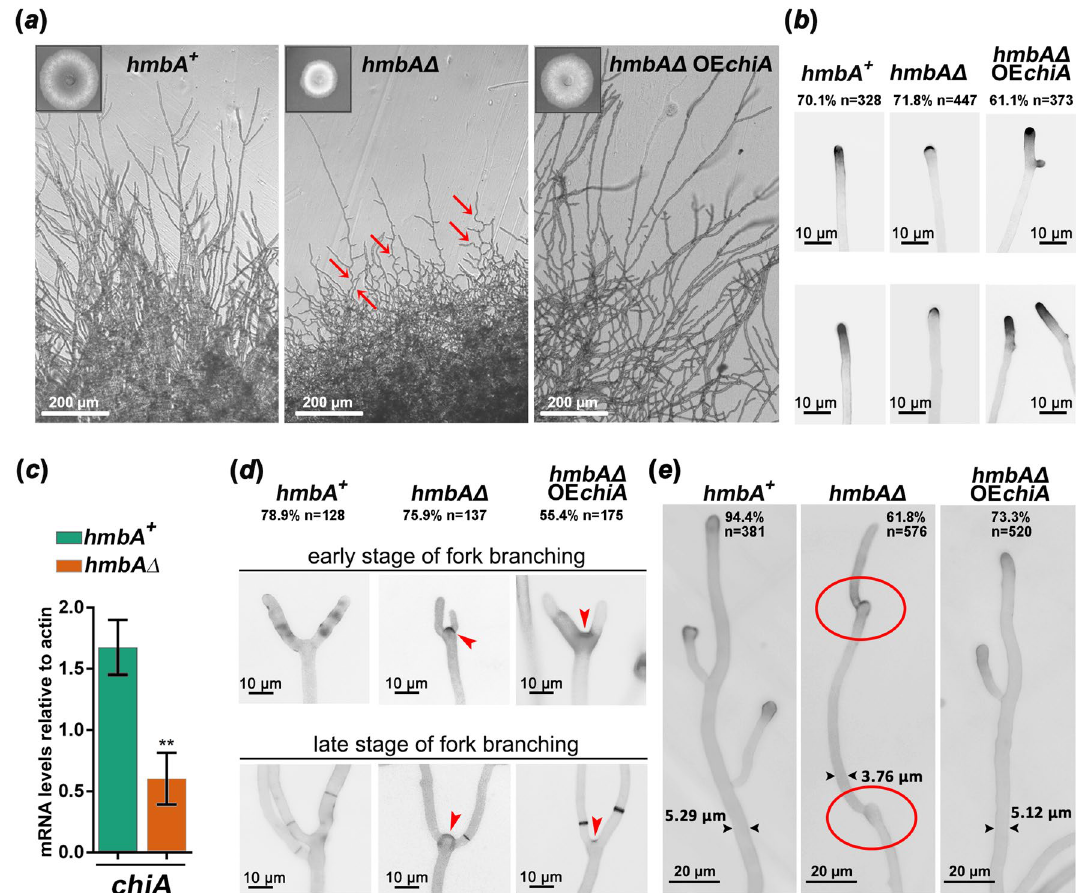
Figure 6. Downregulation of chiA altered morphology and chitin distribution in hmbA∆ . ( a ) The images show the morphology of elongated hyphae across three tested strains. Bright field images were documented with Leica DMI 4000B, DFC295 detector. Scale bars are shown. Red arrows denote zig-zag shaped hyphae. Insets show colonies grown on glucose-nitrate minimal medium at 37 °C for 3 days. ( b ) The images show Calcofluor White staining of chitin at the hyphal tips across three tested strains. Scale bars are shown. Microscopy was carried out with Zeiss Axioobserver 7 Axiocam 503 mono detector with DAPI filter setting. ( c ) The figure shows the mRNA levels of chiA in the tested strains measured by RT-qPCR. Strains were grown on glucose-nitrate minimal medium at 37 °C for 9 h. RT-qPCR data were processed according to the standard curve method 44 with γ-actin transcript ( actA /AN6542) as reference. Standard deviations of three independent experiments are shown. Primers are listed in Supplementary Table S4. ( d ) The images show the fork-branching at the hyphal tips of the tested strains at early and later stages of fork-branching. Arrowheads denote the relicts of hyphal tips that underwent fork-branching. Scale bars are shown. ( e ) The images show hypha elongation across three tested strains. Samples were stained with Calcofluor White. Scale bars are shown. Red circles in midsections of elongated hyphae mark the relicts of arrested hyphal tips that underwent re-initation of polar growth